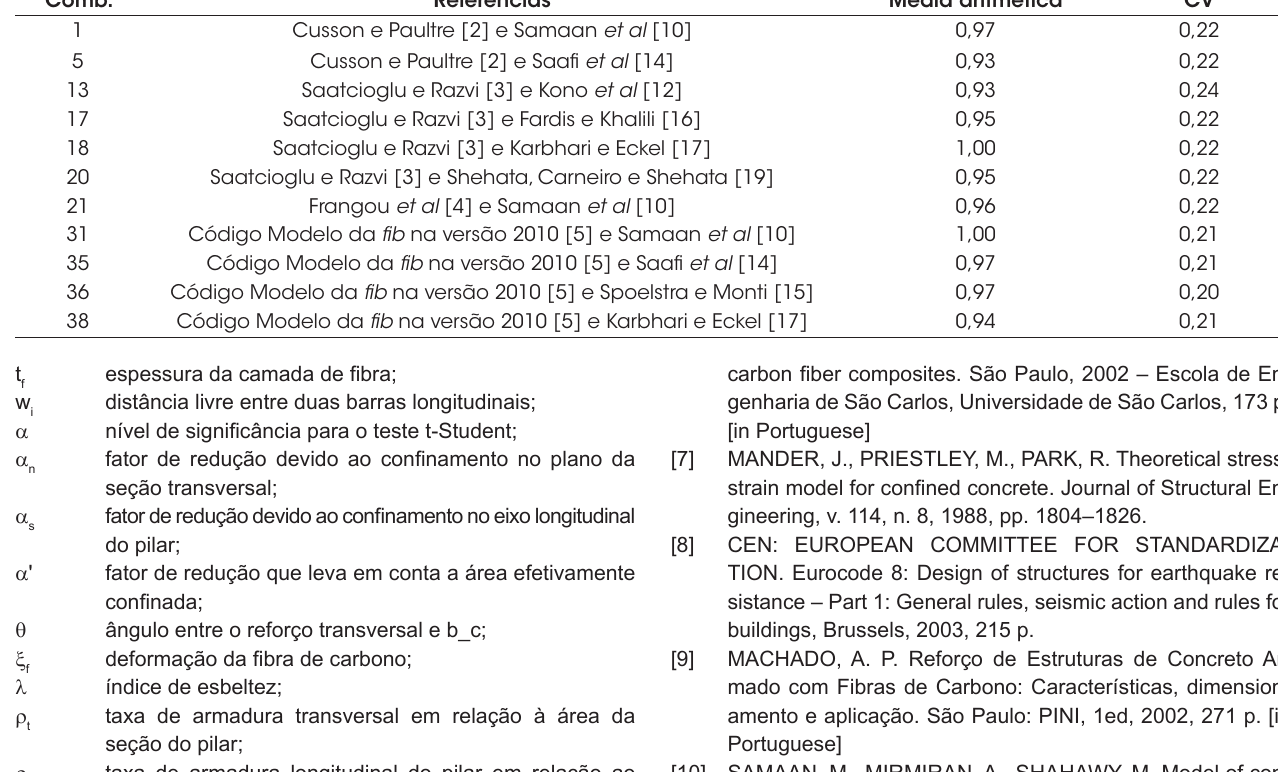
Combinações de modelos de cálculo que obtiveram as melhores previsões de resistência